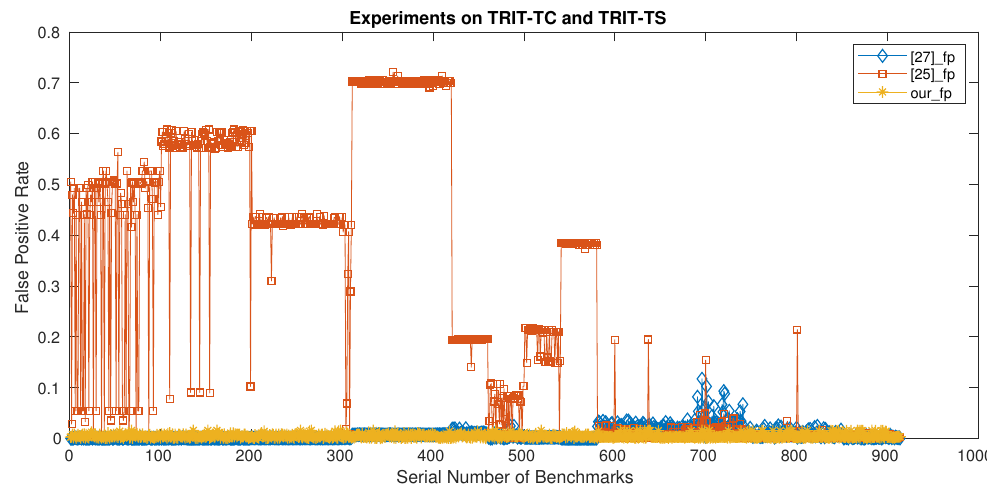
Figure 6. Experiments on TRIT-TC and